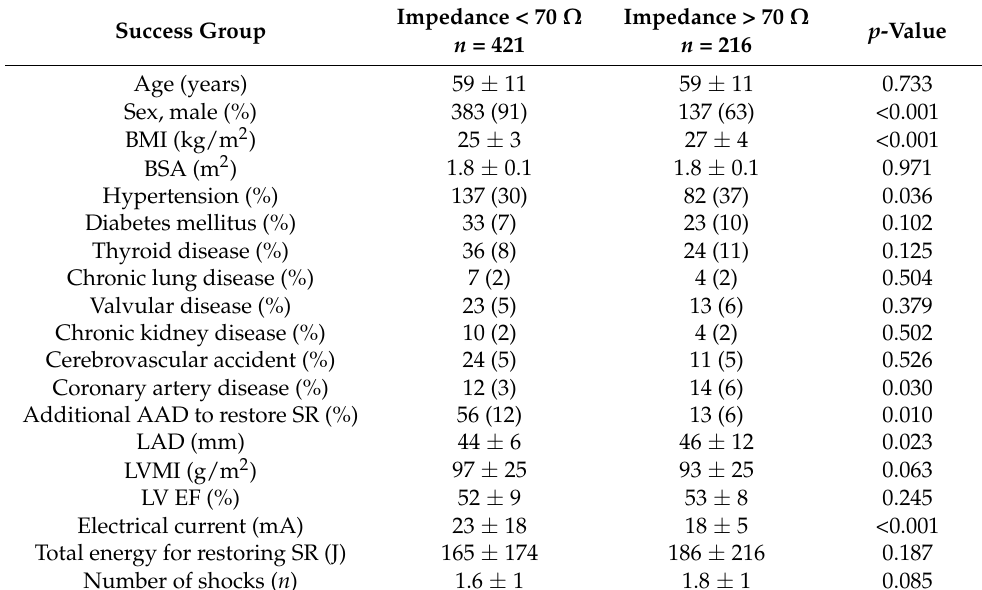
Baseline and electrical characteristics of the patients with high (>70 Ω ) and low (<70 Ω )